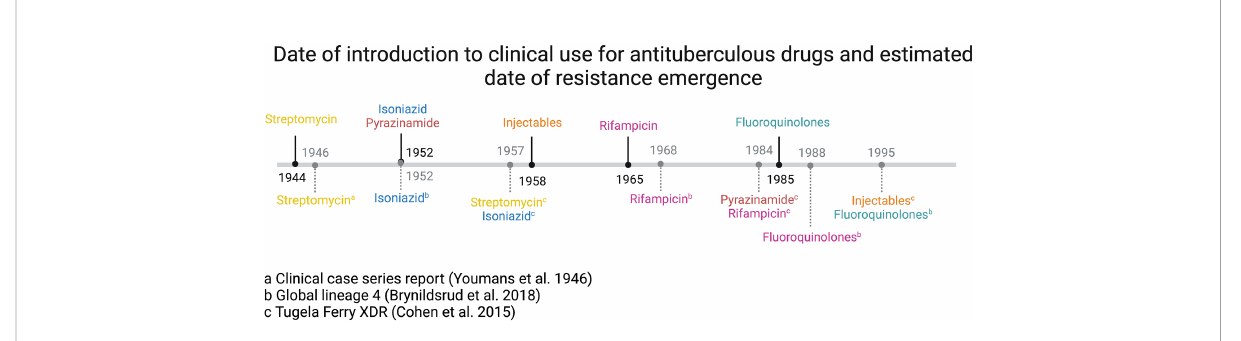
FIGURE 2 Date of introduction to clinical use for antituberculous drugs (above line, denoted by solid black line) and estimated date of resistance emergence (below line, denoted by grey dashed line) (Ektefaie et al.,